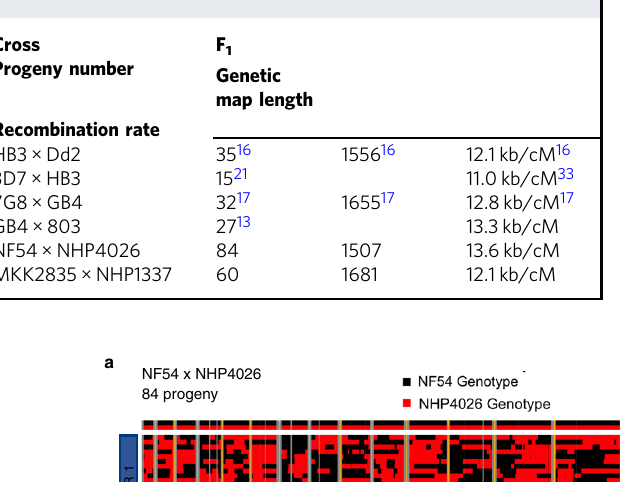
Table 2 Number of progeny, genetic map length and recombination rate for historic P. falciparum genetic crosses, the NF54 × NHP4026 cross and the MKK2835 × NHP1337 cross.